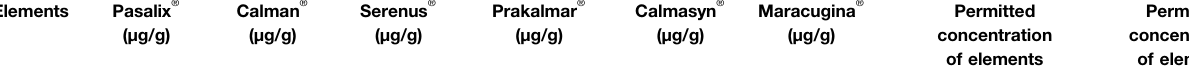
TABLE5| Concentration ofquanti fi edchemicalelements(µg/g)inherbalmedicinescomparedwithpermitted concentration ofelementsimpuritiesforindividualcomponent option established by USP (USP, 2021) and FB (Agência Nacional de Vigilância Sanitária/Fundação Oswaldo Cruz, 2010). Elements